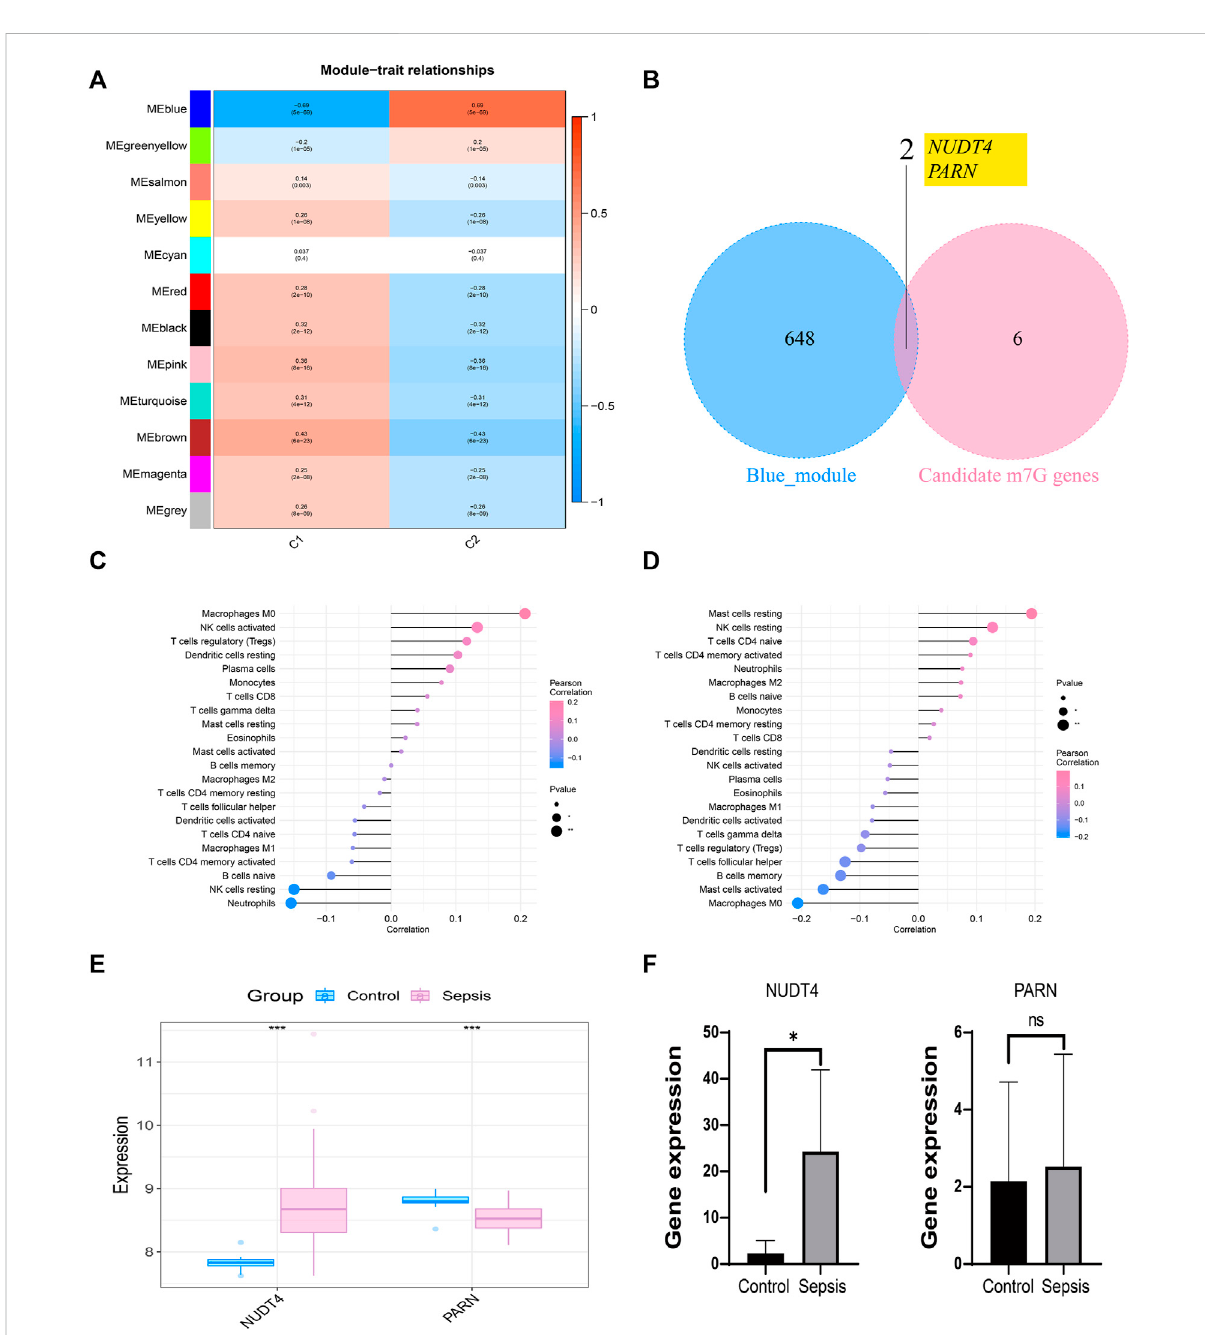
FIGURE 5 Construction of weighted co-expression network and identi fi cation of key genes. (A) The heatmap of the correlation between the module characteristic genes and the clinical of sepsis subtypes. The blue module with the highest correlation was selected for subsequent analysis. (B) Identi fi cation of key genes in sepsis. (C) Correlation between NUDT4 and immune cells. (D) Correlation between PARN and immune cells. (E) Veri fi cation of the expression of key genes in external validation dataset. (F) The RT-PCR validation of key genes